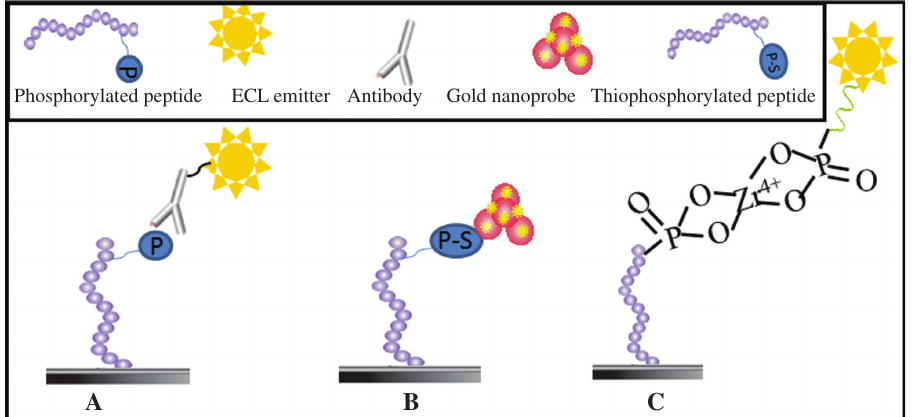
Figure 4 Scheme of possible configurations of the ECL peptide-based bioassay for the detection of protein kinase.